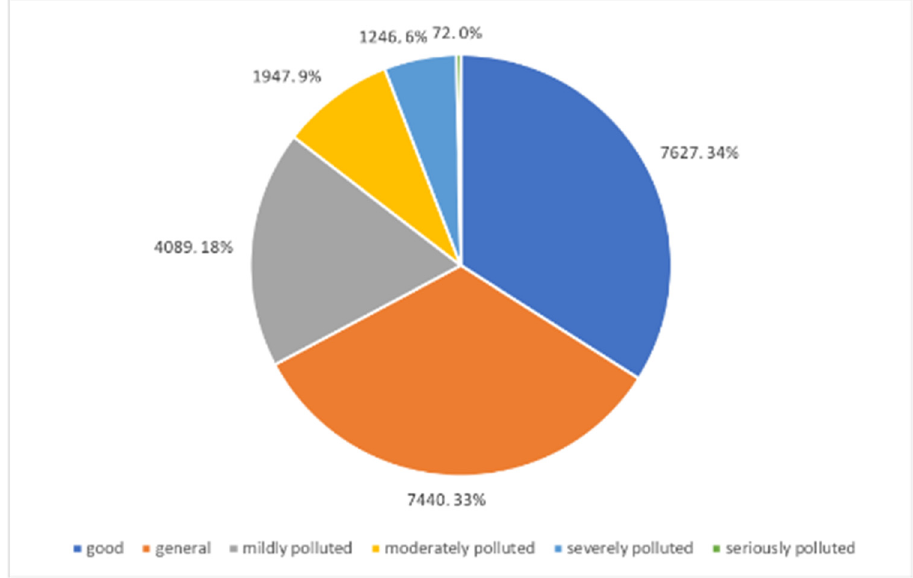
Figure 1. The percentages of PM 2.5 levels in Shenyang. Meteorological data were gathered at hourly intervals corresponding to the PM 2.5 concentration values, which were temperature, atmospheric pressure, relative humidity, wind direction, speed. We preliminarily analyzed the correlations of PM 2.5 concentrations and each meteorological feature using scatter grams shown in Figure 2. Figure 2 indicates that when the temperature was very low (lower than − 20 °C), the concentration of PM 2.5 was also relatively low; when the atmospheric pressure was high, the PM 2.5 concentrations were relatively low; when the relative humidity was lower than 20%, the PM 2.5 concentra- tions were relatively low; and when the wind speed was high, the PM 2.5 concentrations